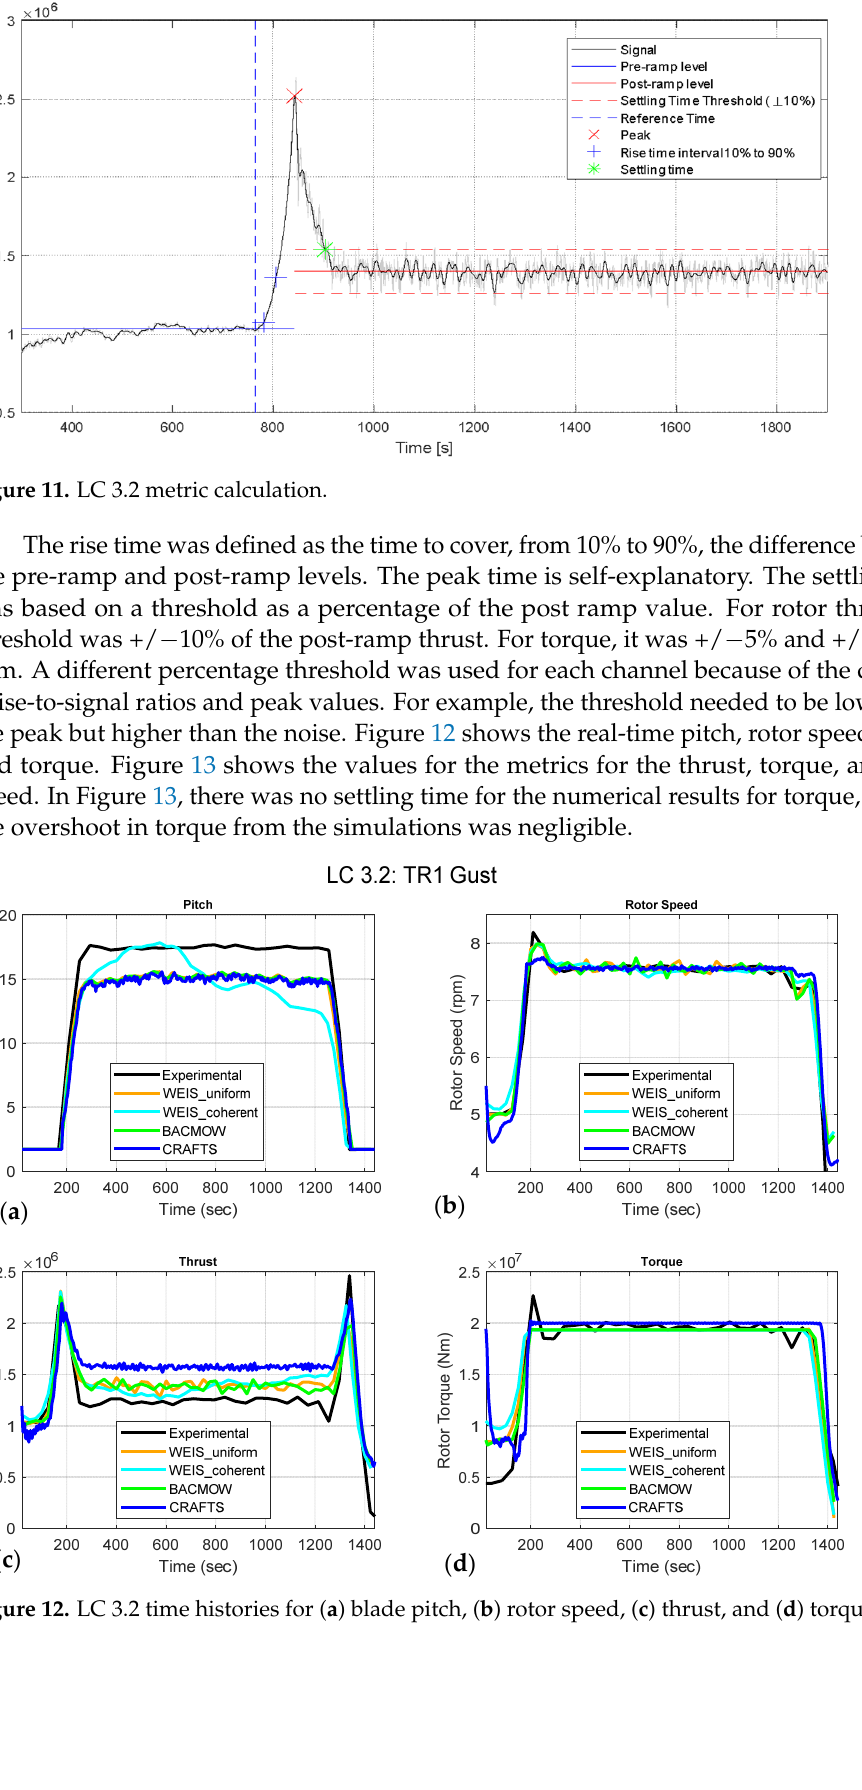
Figure 12. LC 3.2 time histories for ( a ) blade pitch, ( b ) rotor speed, ( c ) thrust, and ( d ) torque.